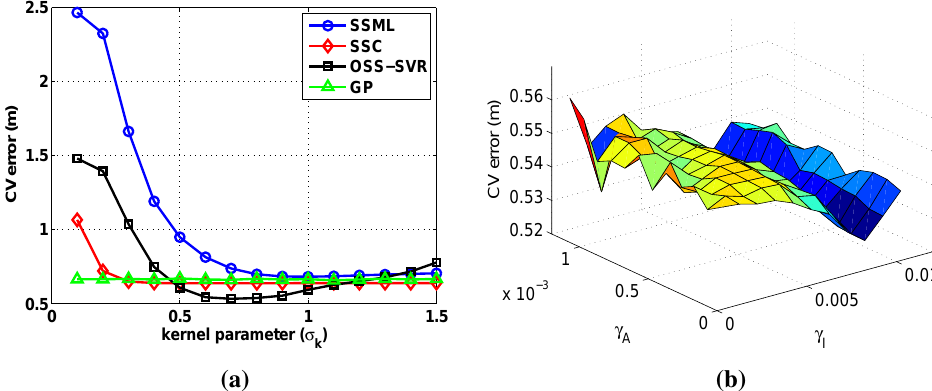
Figure 2. CV (cross-validation) error over the validation set as ( a ) a function of the kernel parameter for all compared methods and ( b ) a function of regularization parameters γ for online semi-supervised